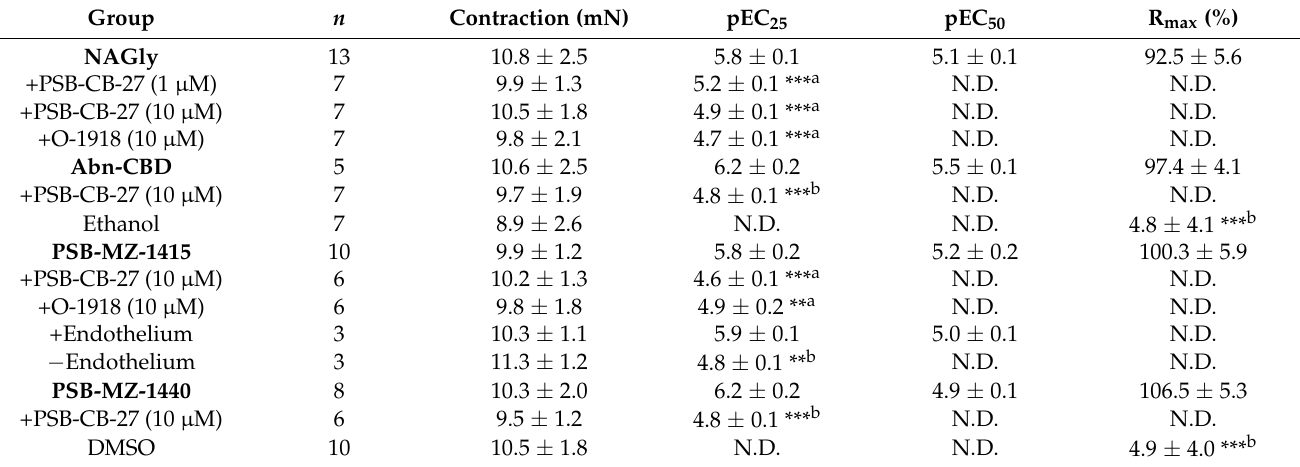
Data are expressed as the mean ± SEM and represent contractile responses to U46619 (0.01 µ M). n, number of patients; ** p < 0.01, *** p < 0.001; compared to the respective control as determined by a one-way ANOVA followed by Dunnett’s post hoc test or b Student’s t -test. N.D., not determined.